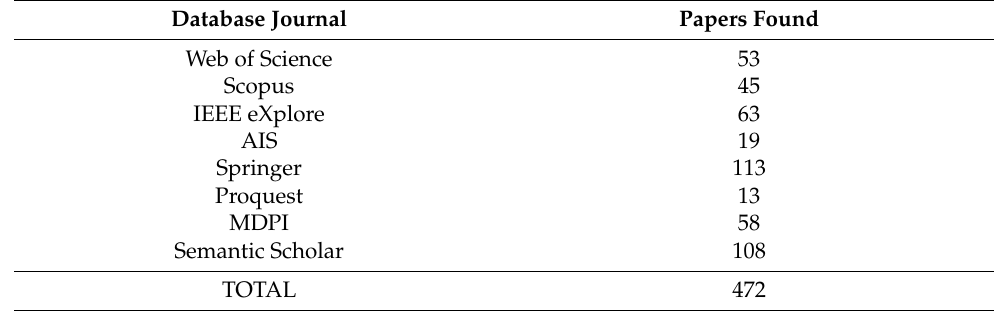
Table 2. Papers found/database